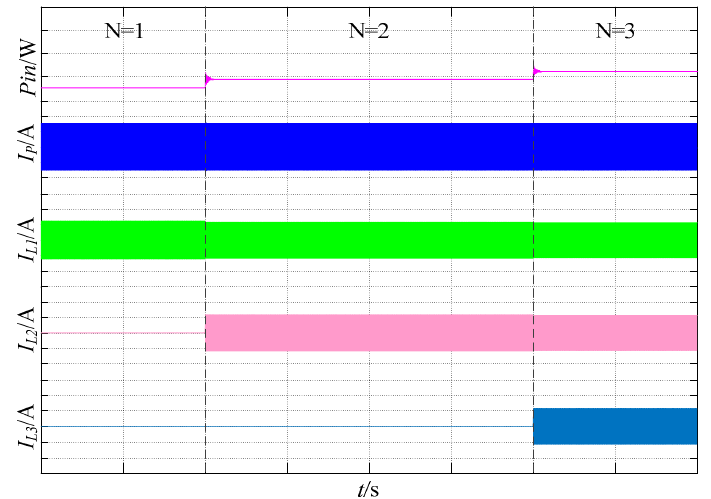
Figure 9. Experimental waveforms of input power, transmitting coil current and load current.